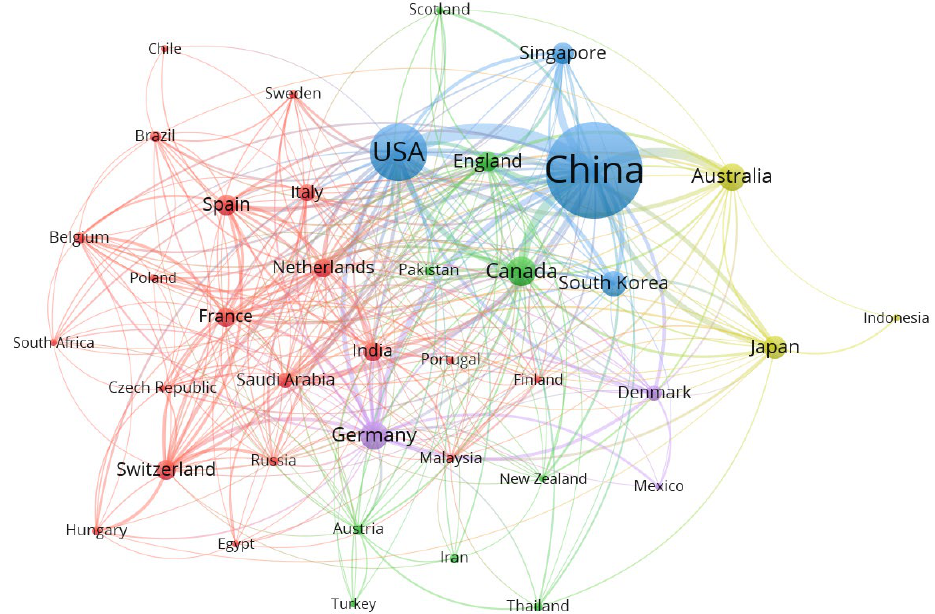
Figure 2. Spectrum of cooperation in different countries or regions from 2005 to 2022.